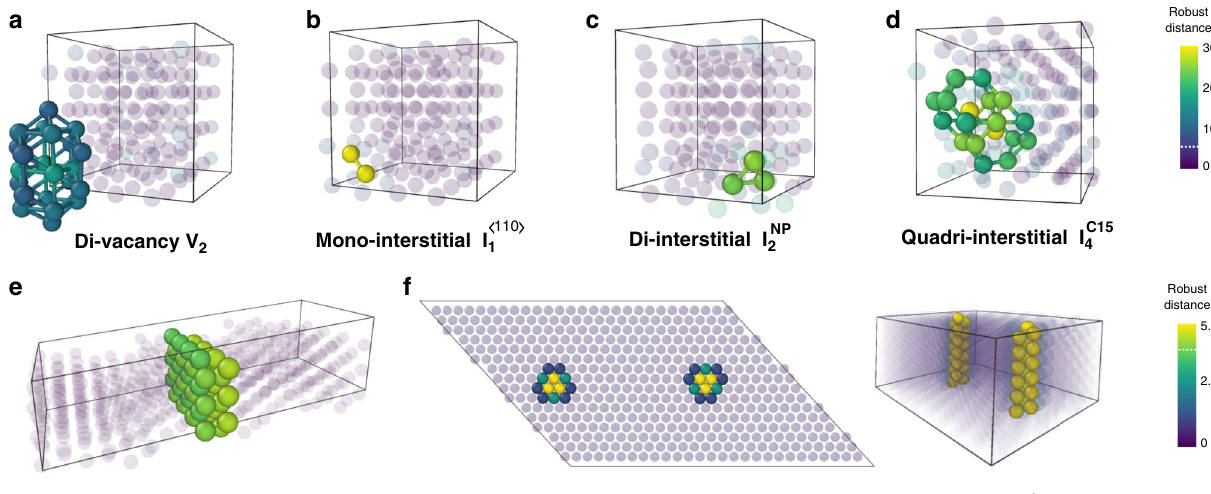
h 111 i screw 2